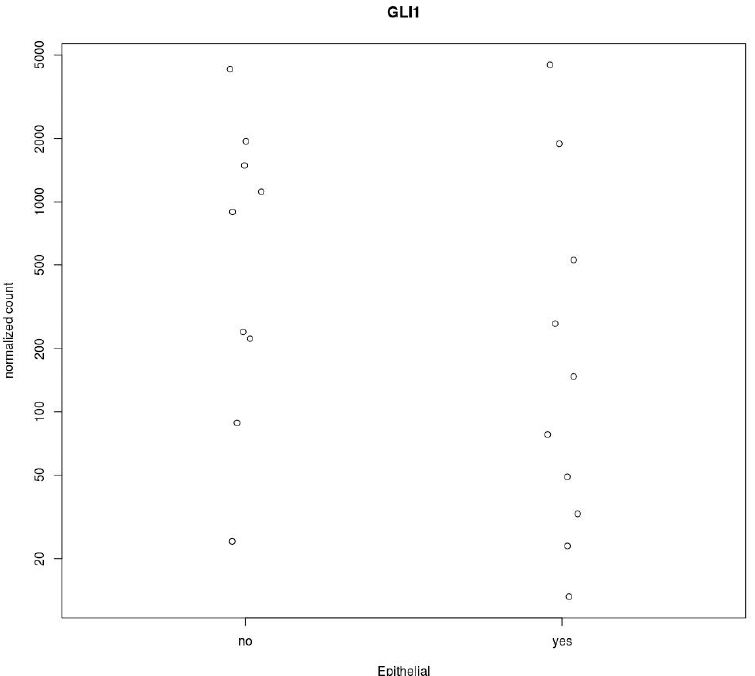
Figure 6. Differential expression analysis of GLI1 gene between biphasic and epithelioid MPM. The analysis was drawn using the Deseq2-package, PlotCounts. The GLI1 gene has Log2FoldChange < 0, indicating that the gene is down-regulated in epithelial tissues, but it is not significantly differentially expressed since padj = 0.81. Y axis: normalized count; X axis: Histological subtype. Epithelial = yes; non-epithelial = no.